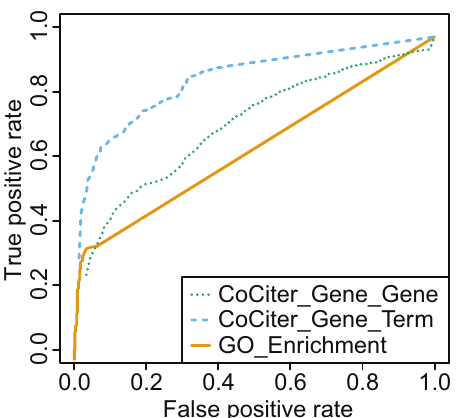
Figure 2. ROC curves of CoCiter and GO enrichment analysis by Fisher exact test. The analysis was based on 2097 gold standard positives (GSP) and 603 gold standard negatives (GSN) selected from the overlapping and non-overlapping GO and KEGG annotations, respectively (Supplemental Methods in File S1). The curve for CoCi- ter_Gene_Gene association function was obtained by using the KEGG genes and GO genes as input, while that for CoCiter_Gene_Term association function was obtained using the KEGG pathway keywords as terms and GO genes as input.